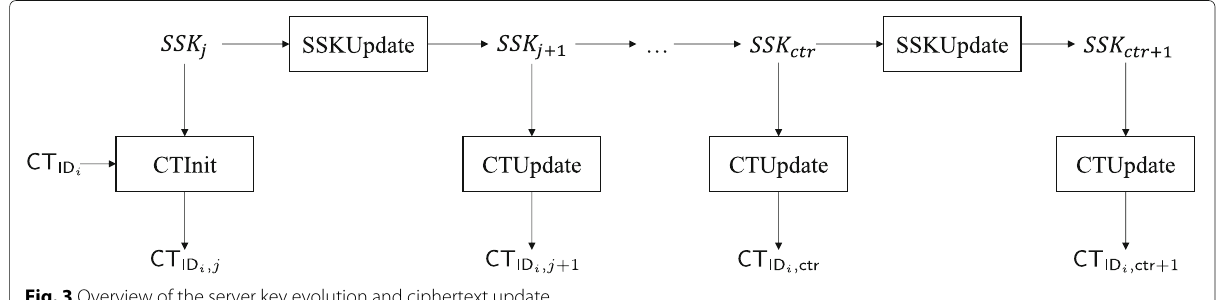
Fig. 3 Overview of the server key evolution and ciphertext